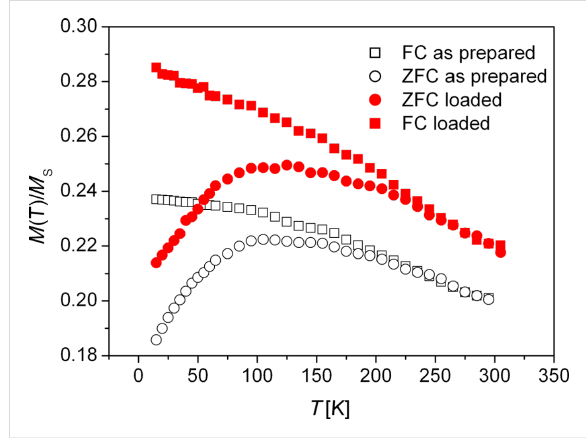
Figure 7: ZFC (circles) and FC (squares) magnetization curves of the Fe nanoparticles embedded in Cu film in the as-prepared state (open symbols) and after loading of the Ta substrate with H (filled red symbols) at H = 100 Oe. The magnetization values have been normal- ized to the saturation magnetization M s at 10